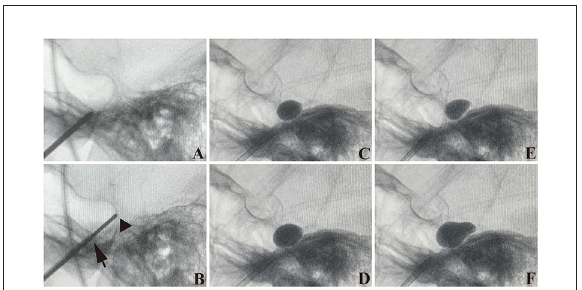
FIGURE2 Puncture process. (A) Trocar (with stylet in) goes near the foramen ovale (FO). (B) The tip of the cannula is at the FO (arrow) but does not penetrate. The tip of the wider needle comes across the clivus on the projection (triangle). (C,E) A small 1.5 mL contrast injection to test the proper position, (E) is likely a pear. (D,F) Enlargement of the balloon (C,E) . (D) is not a pear. (F) is a perfect pear. (C–F) were from one PBC